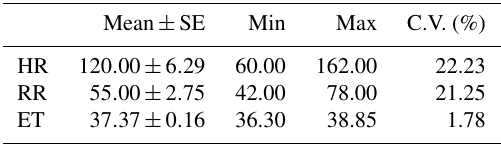
Table 1. Descriptive statistics for heart rate (HR), respiratory rate (RR) and eye temperature (ET) measurements obtained for the meat goats